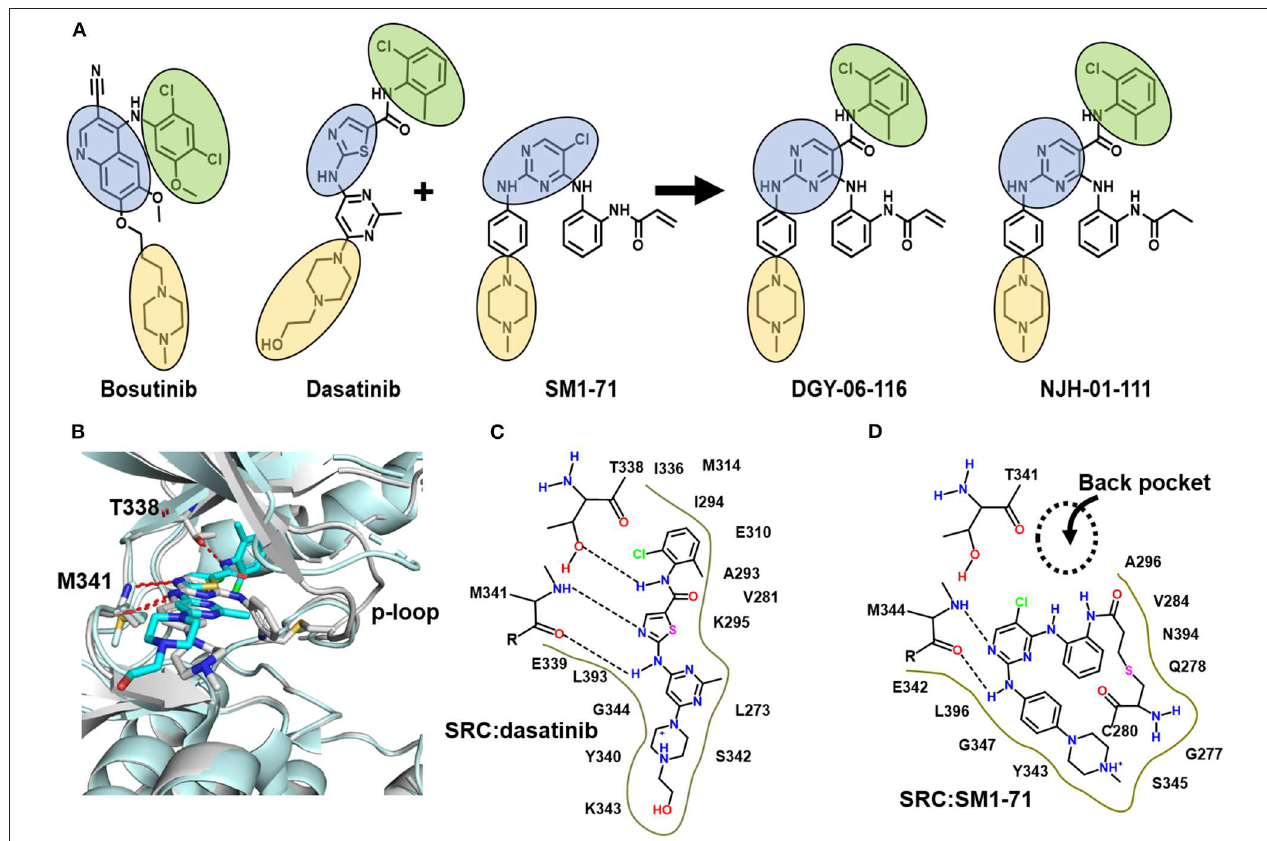
FIGURE 1 | DGY-06-116 is a hybrid of dasatinib and SM171. (A) Src inhibitors are composed of a kinase hinge-binding component (blue), back pocket-binding component (green), and solvent-exposed component (yellow). DGY-06-116 (second from right) resulted from hybridizing the SM1-71 core (third from left) with the back-pocket component of dasatinib (second from left). NJH-01-111 (first from right) is a non-covalent analog. (B) Superposition of Src-dasatinib (PDB: 3G5D; cyan) and Src-SM1-71 (PDB: 6ATE; gray) structures suggested that the substitution would be tolerated. Schematic representation of interactions between Src and (C) dasatinib or (D) SM1-71. Dotted lines are hydrogen